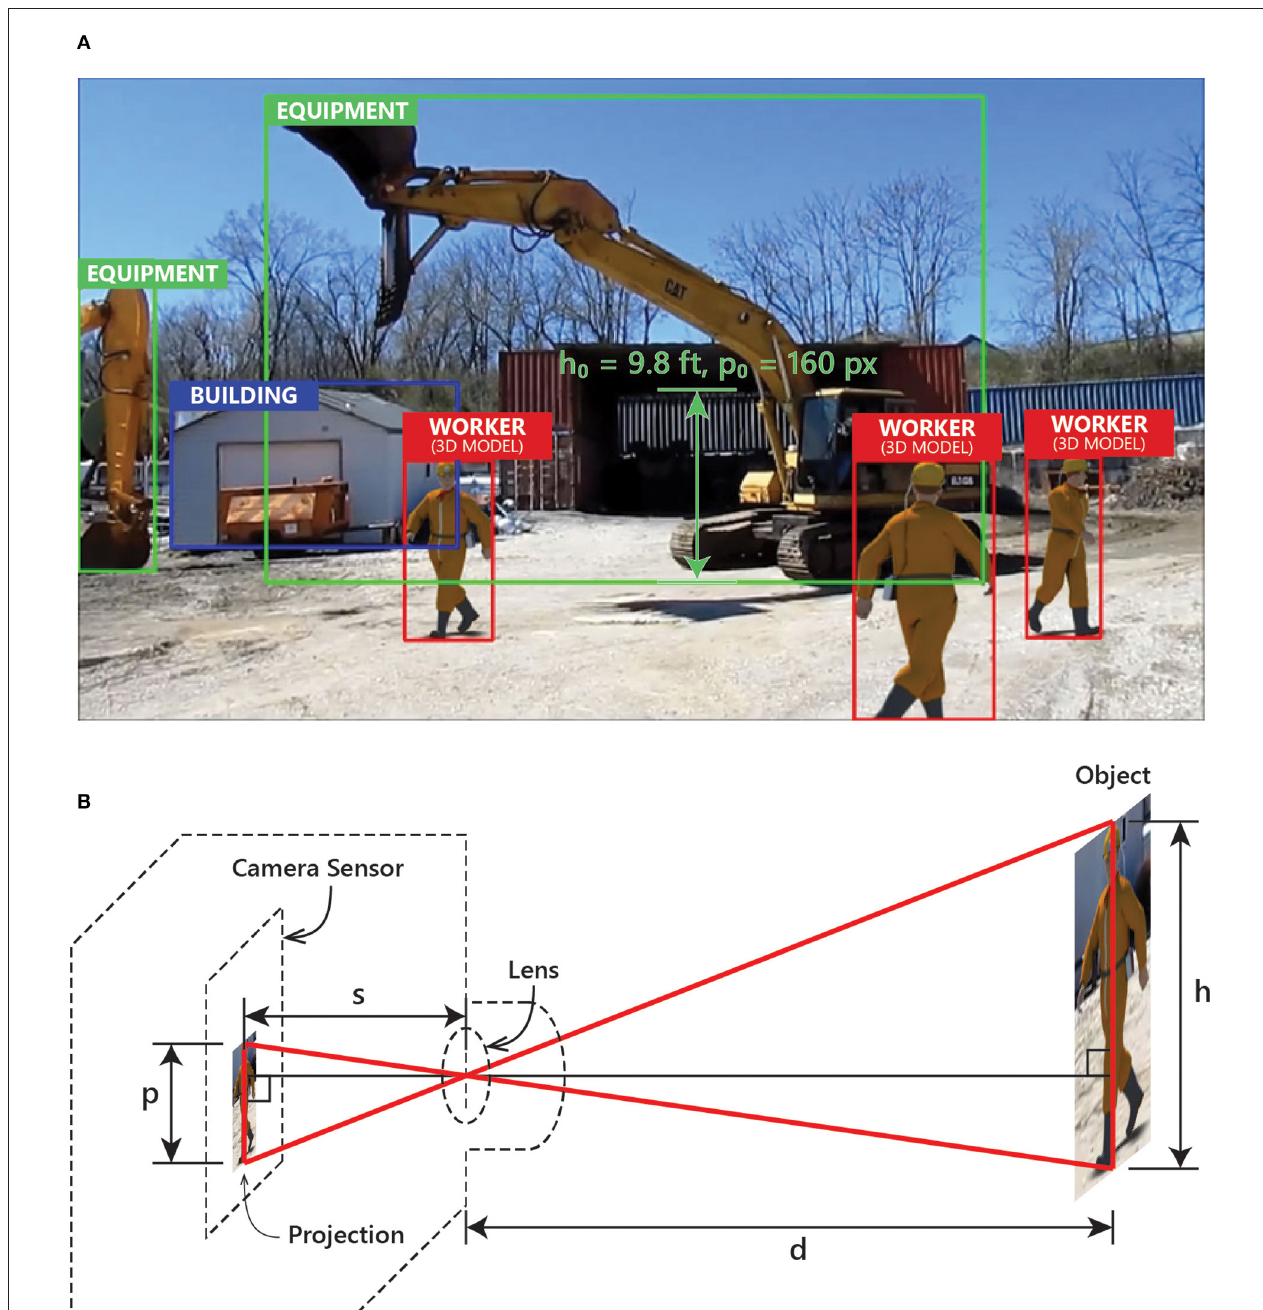
FIGURE 5 | Example of (A) a synthetic image and (B) projection of an object on camera sensor.